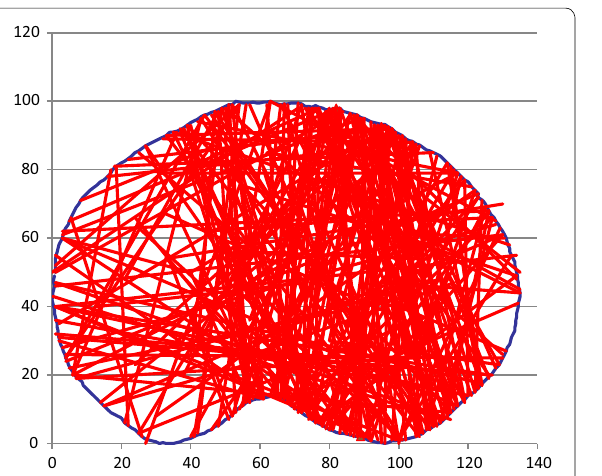
Fig. 4 Superimposition of all fracture lines onto one template